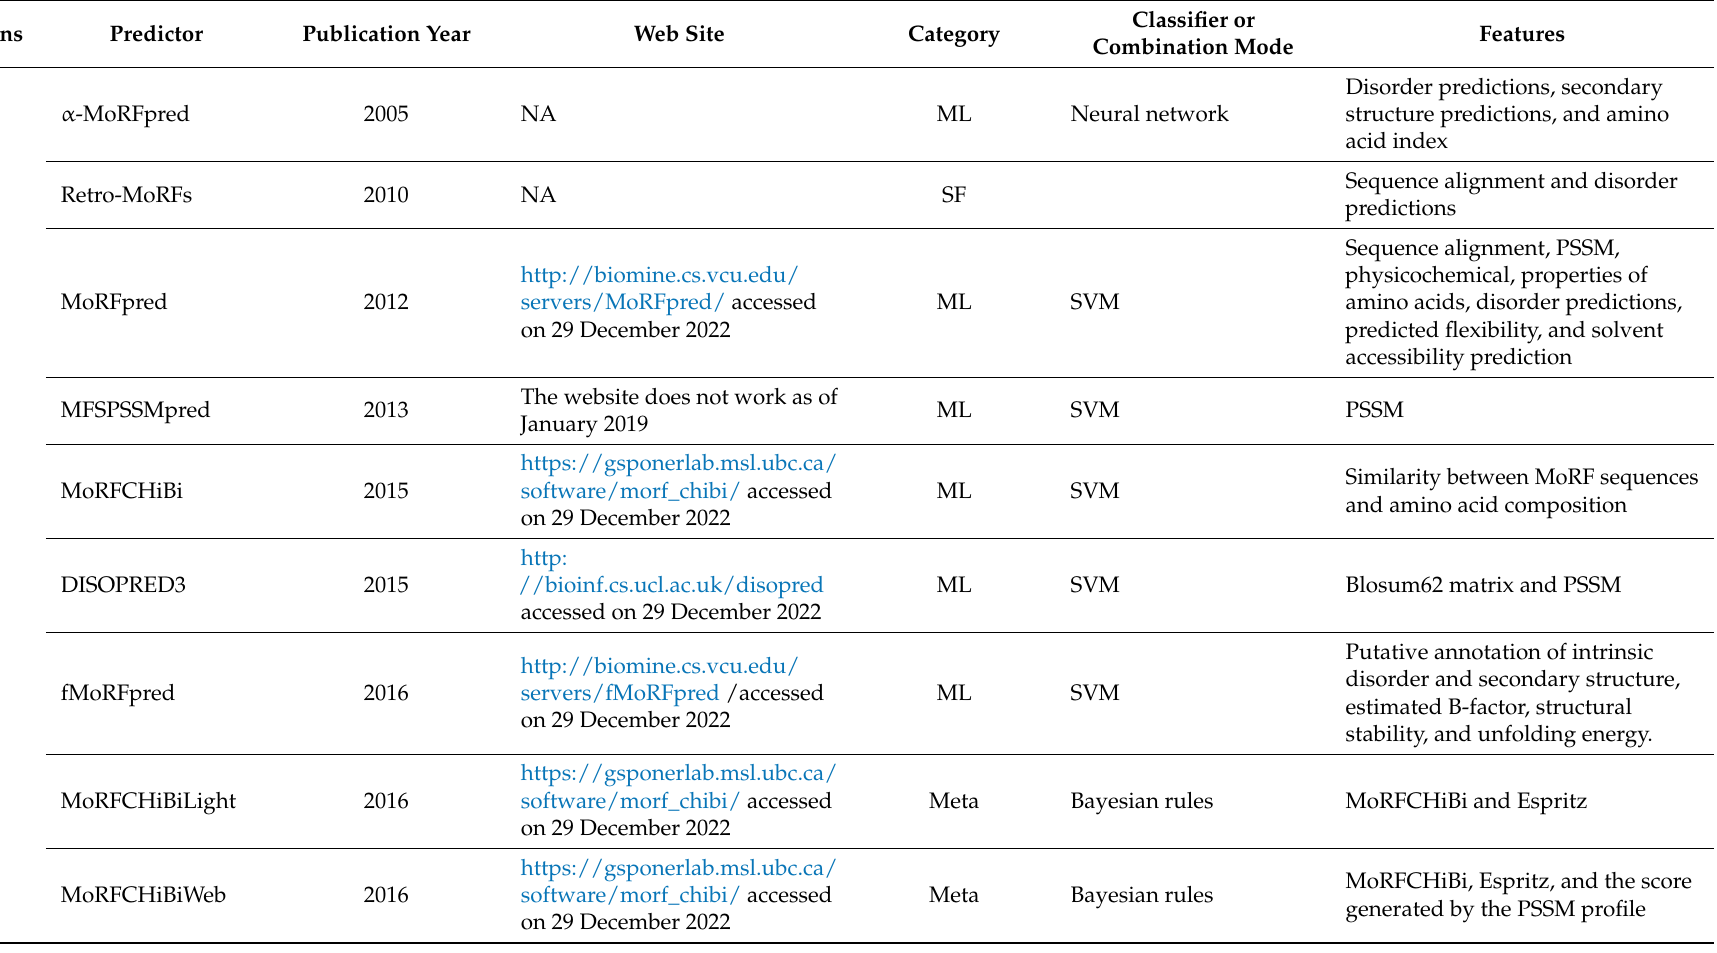
Table 4. Summary of the prediction methods of disordered binding